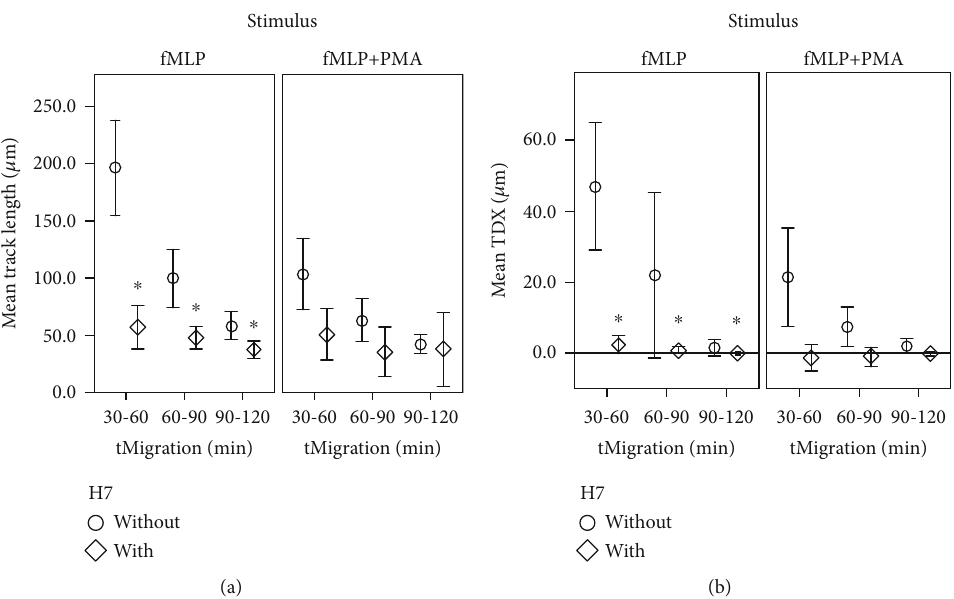
Figure 4: Chemotaxis decreases during H7 exposition. x -axis: 30-minute time intervals tMigration (min), y -axis: (a) mean track length in μ m; (b) mean track displacement along the x -axis TDX in μ m; comparing groups with and without H7; ∗ signi fi cant ( P < 0 : 05 ) compared to the control group without H7; error bars represent standard deviation of measurements.